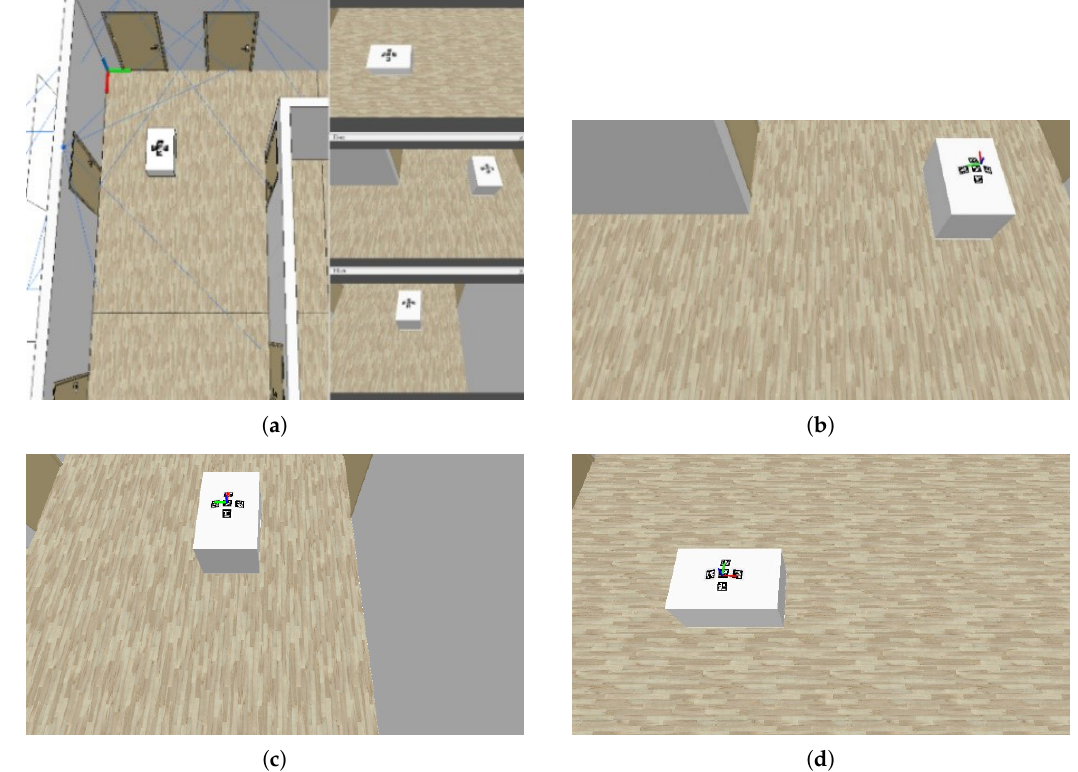
Figure 4. Simulation environment: ( a ) top view; ( b ) red camera view; ( c ) blue camera view; ( d ) yellow camera view. Resolution for every camera was set to 1280 × 720 px this